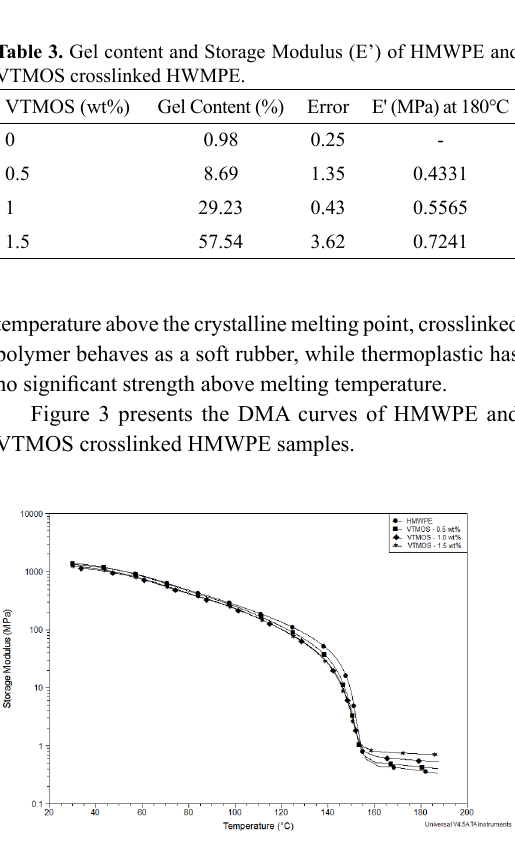
Figure 3. DMA curves of HMWPE and VTMOS crosslinked HMWPE